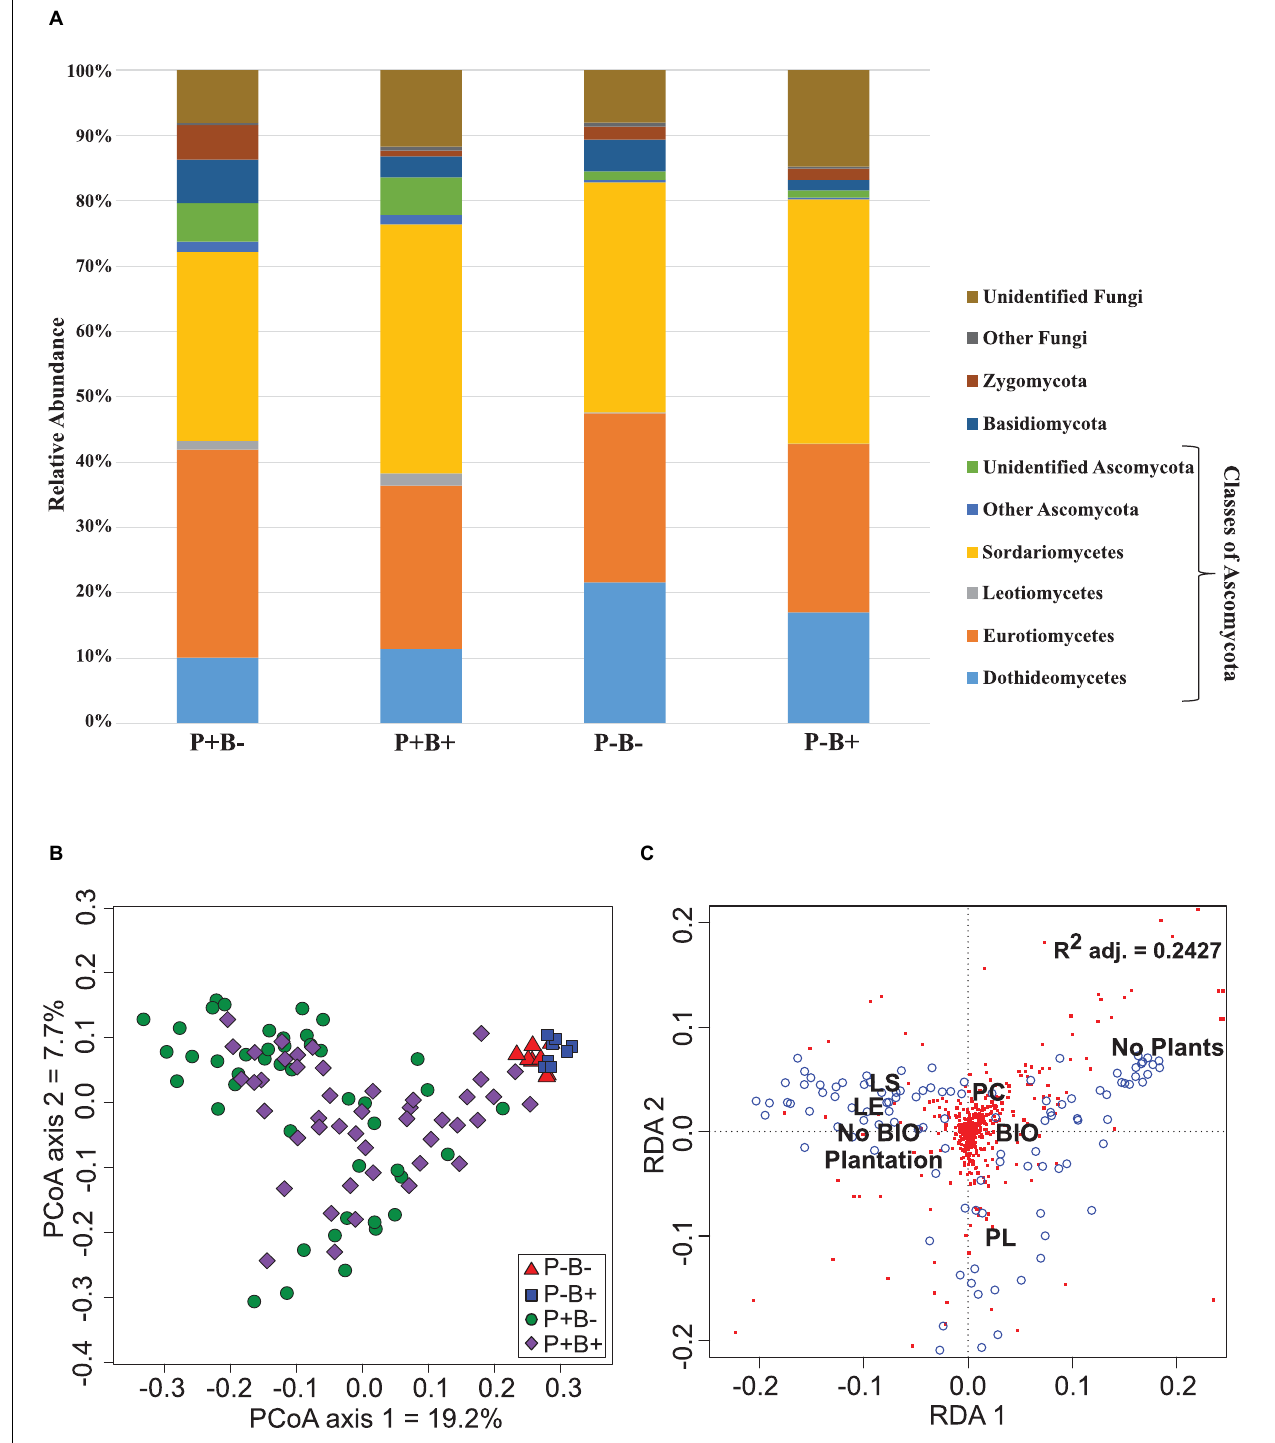
FIGURE 2 | (A) Effect of the plantation and bioaugmentation on the relative abundance of fungal phyla or classes. (B) Principal coordinate analysis based on the Bray–Curtis dissimilarity of fungal communities showing the effect of plantation and bioaugmentation. (C) Redundancy analysis (RDA) showing the relation between the abundance of fungal OTUs and the factors Bioaugmentation, Plantation, and Plant species identity. The adjusted R 2 value indicates the amount of variance in fungal community composition accounted for by the constraining factors (Bioaugmentation, Plantation, and Plant species identity). The location of labels represents factor centroids (Bio, Bioaugmentation; LE, Lycopus europaeus ; LS, Lythrum salicaria ; PC, Panicum capillare ; PL, Persicaria lapathifolia ). Red squares indicate bacterial OTUs. Blue open circles represent individual samples.